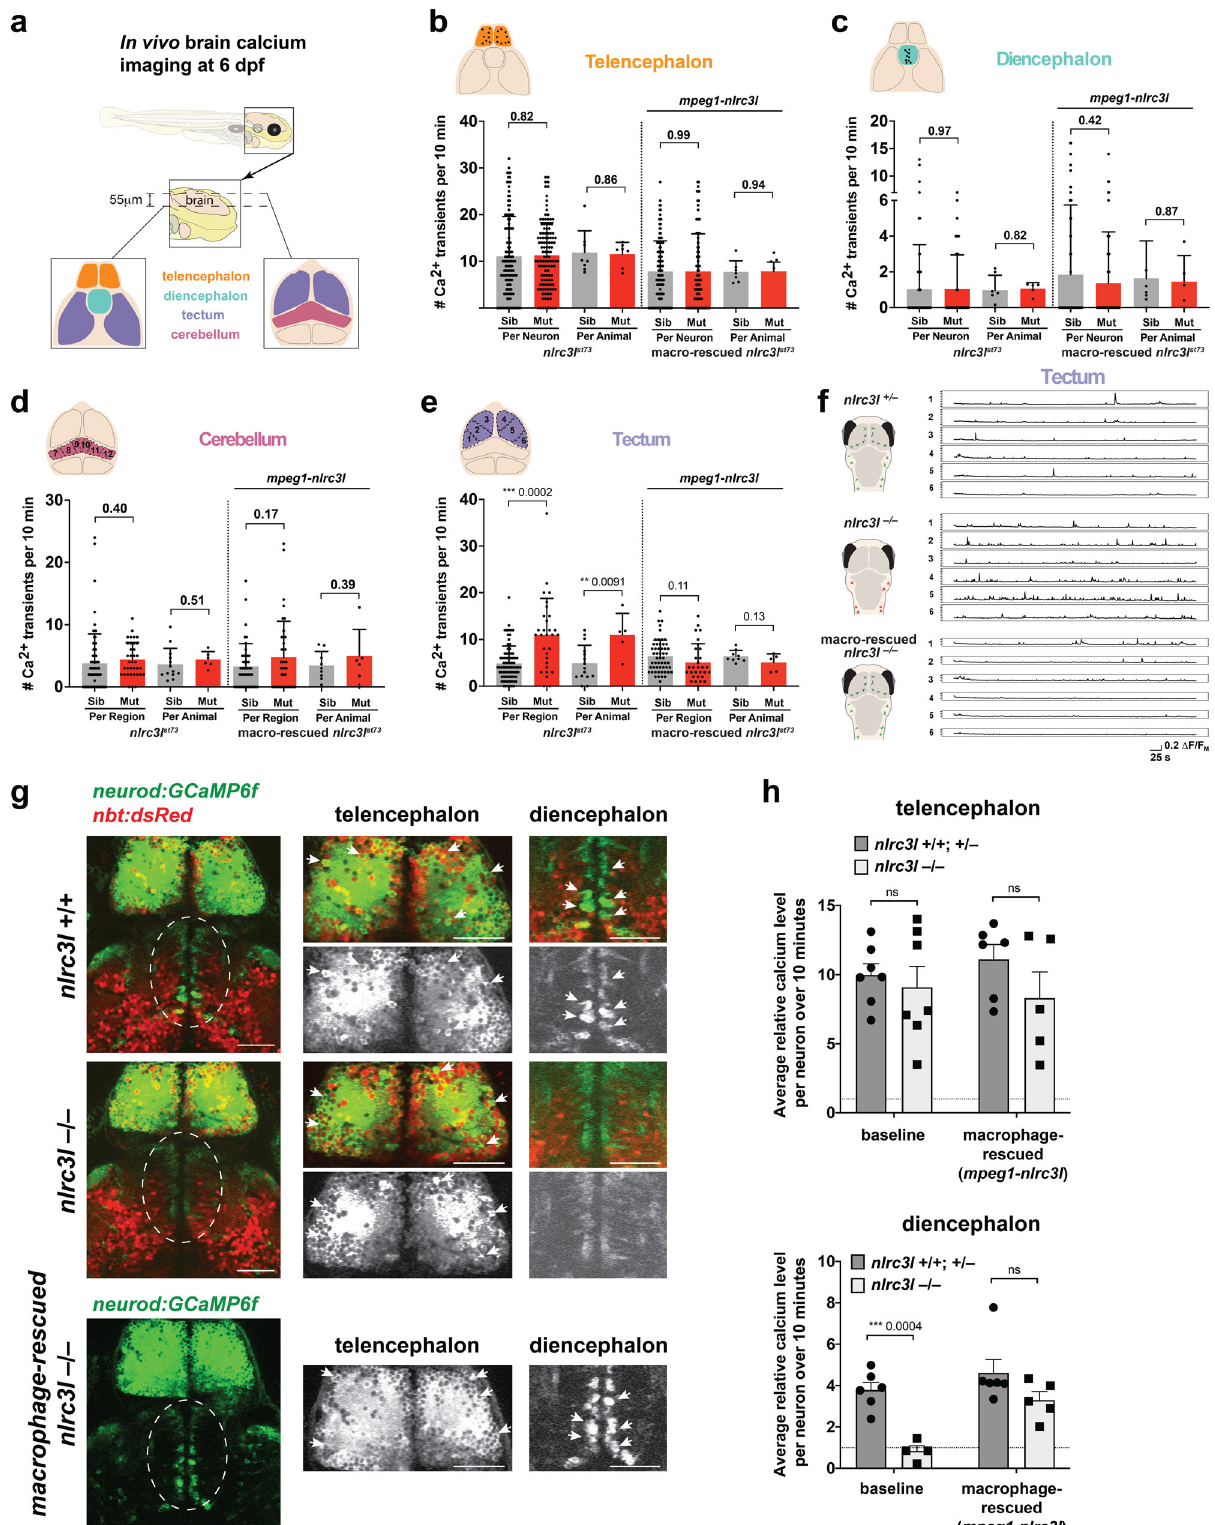
Abnormal in fi ltration of neutrophils in the diencephalic brain disrupts locomotor control . How mutant macrophages may modify CNS circuits that regulate locomotion remains an open question. Because brain in fi ltration and increased circulation of neutrophils were attributed to the systemic in fl ammation in the